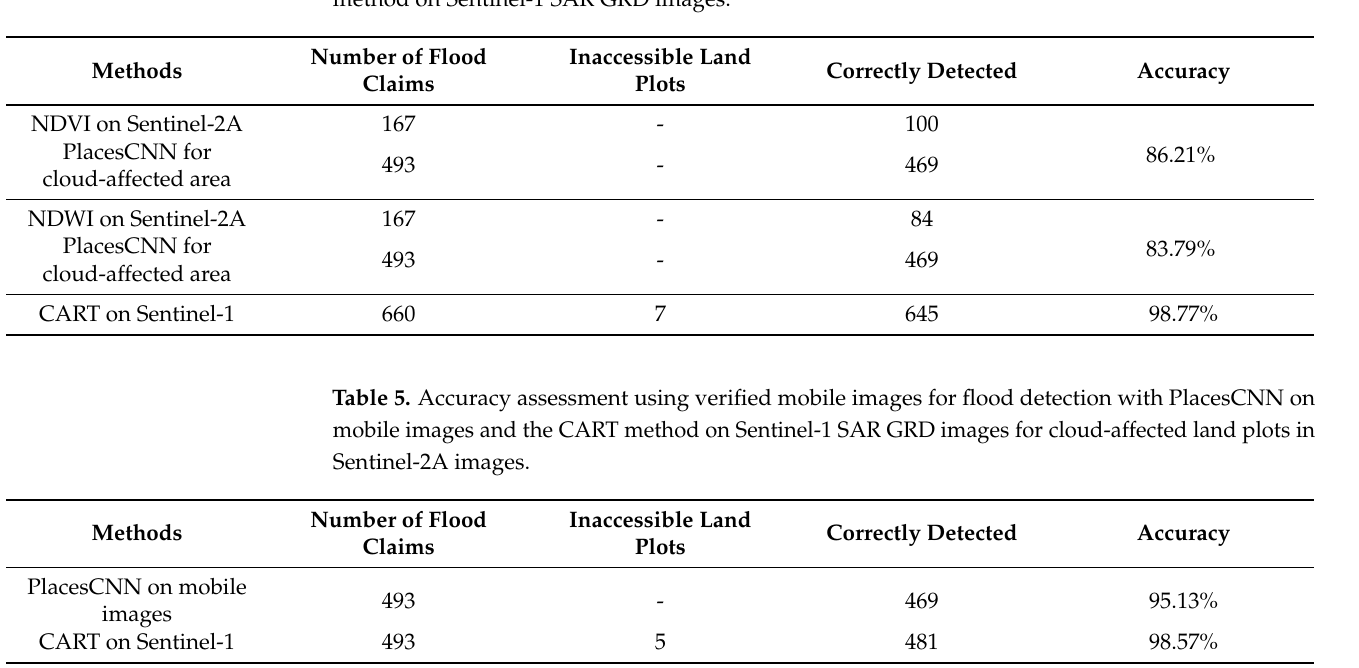
Table 4. Accuracy assessment using verified mobile images for flood detection with the integration of mobile images with Sentinel-2A images in cloud cover areas and overall accuracy of the CART method on Sentinel-1 SAR GRD images.